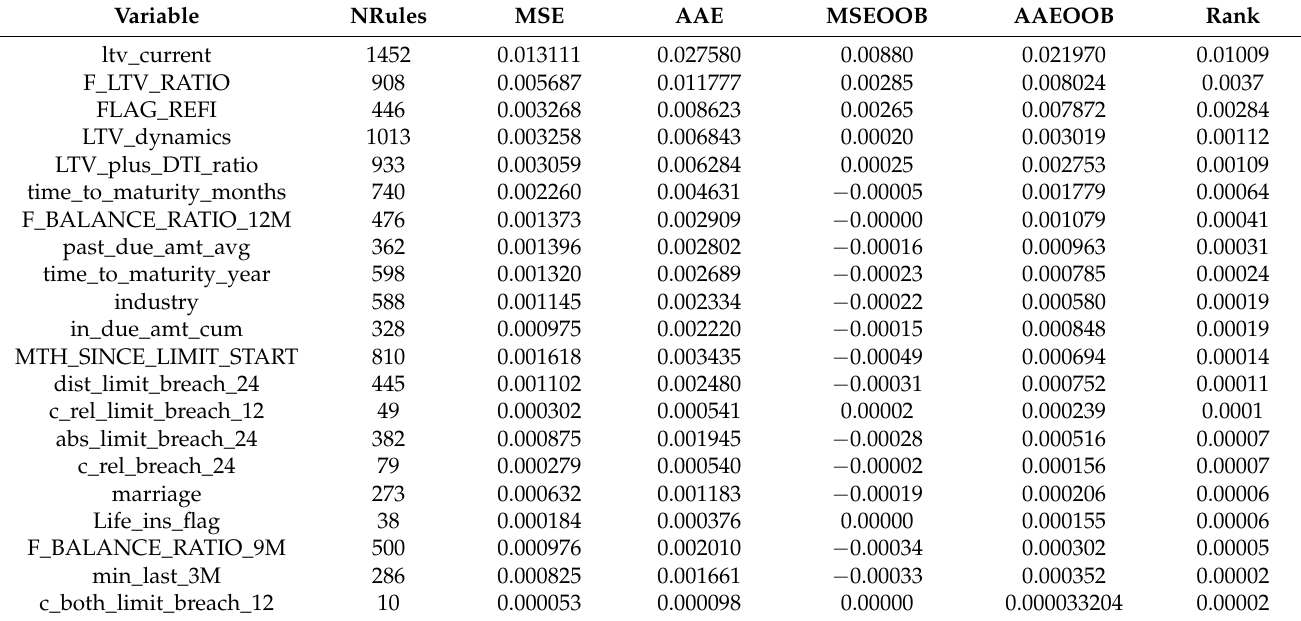
Table 1. Quality statistics of